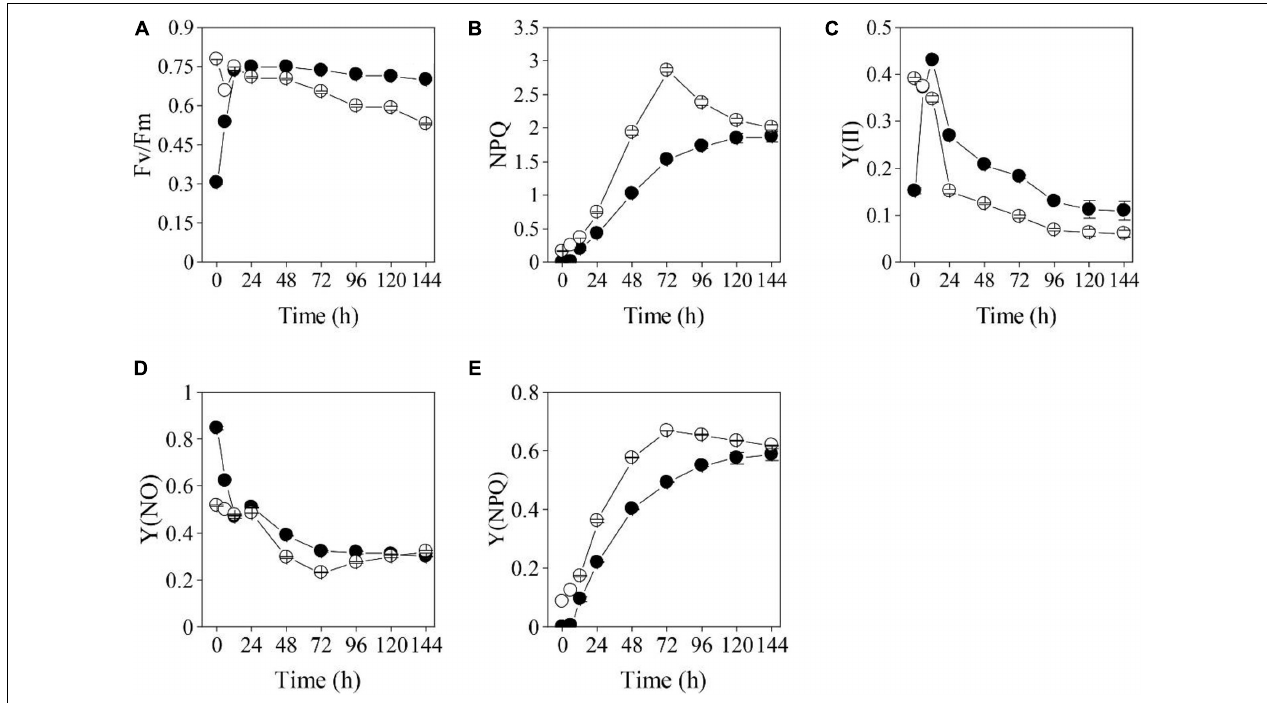
FIGURE 3 | Changes in chlorophyll fluorometry parameters [ (A): Fv/Fm, (B): NPQ, (C): Y(II), (D): Y(NO), (E): Y(NPQ)] for the heterotrophically (filled cycle)- and photoautotrophically (empty cycle)-grown S. acuminatus cells subjected to the high-light and N-limited conditions. The values represent mean ± S.D. ( n =